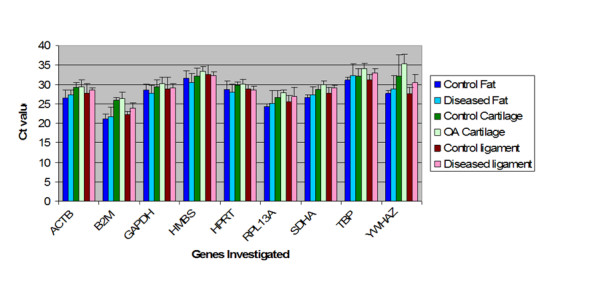
Mean expression values for candidate reference genes (± SD) from healthy and diseased canine infrapatellar fat tissue, canine cartilage and ligament tissue, following RT-PCR analysis.